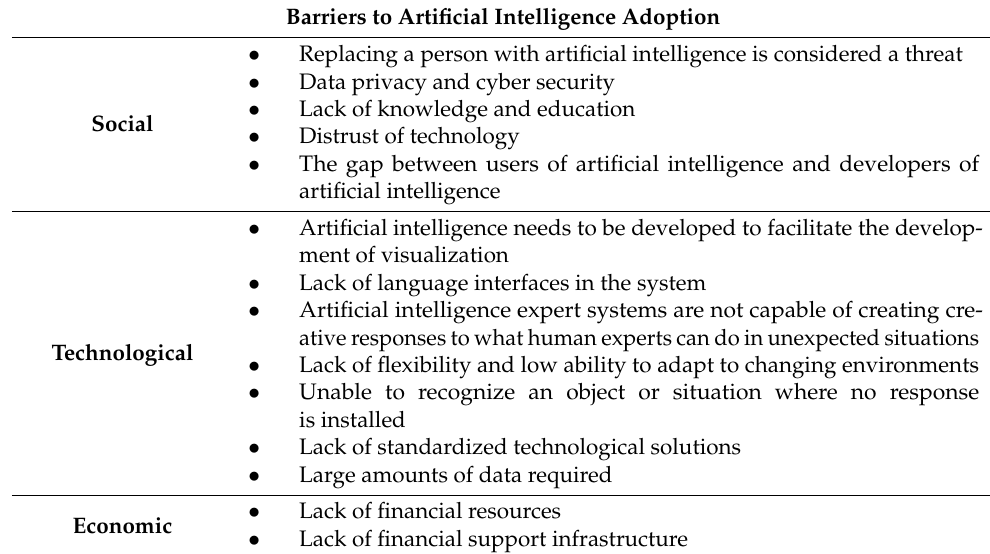
Table 4. Barriers to artificial intelligence adoption (own, based on